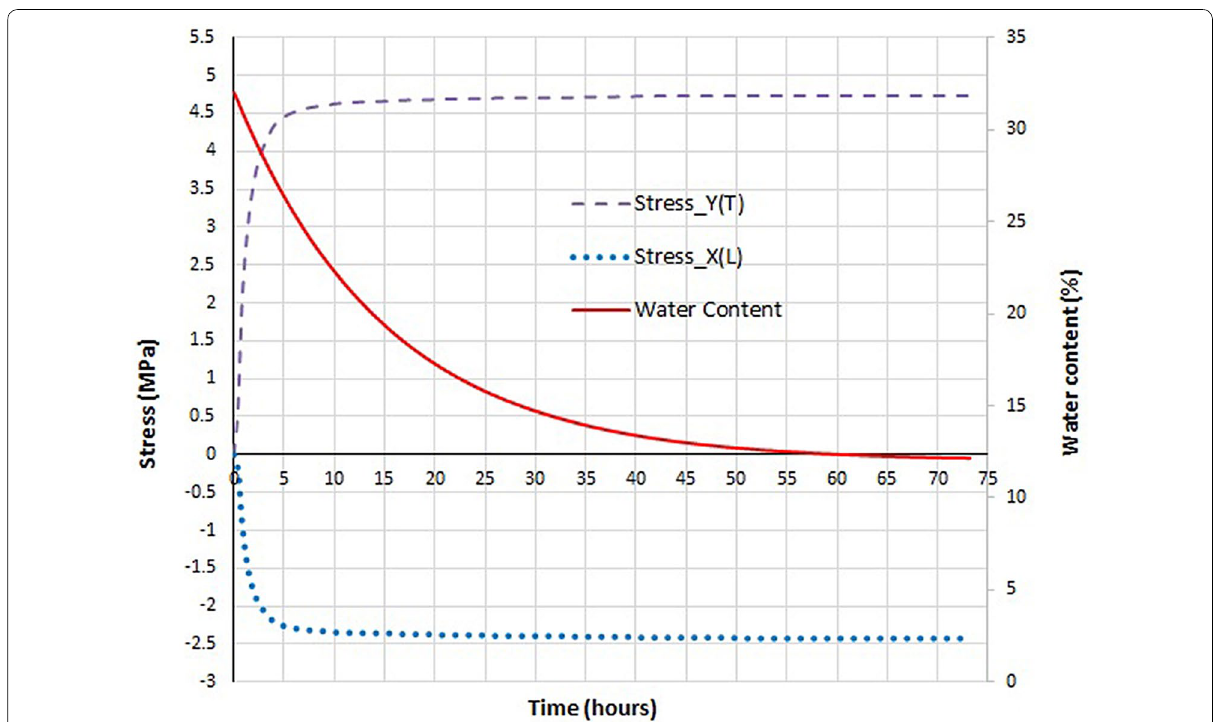
Fig. 16 Evolution of stresses in X and in Y at a surface point of